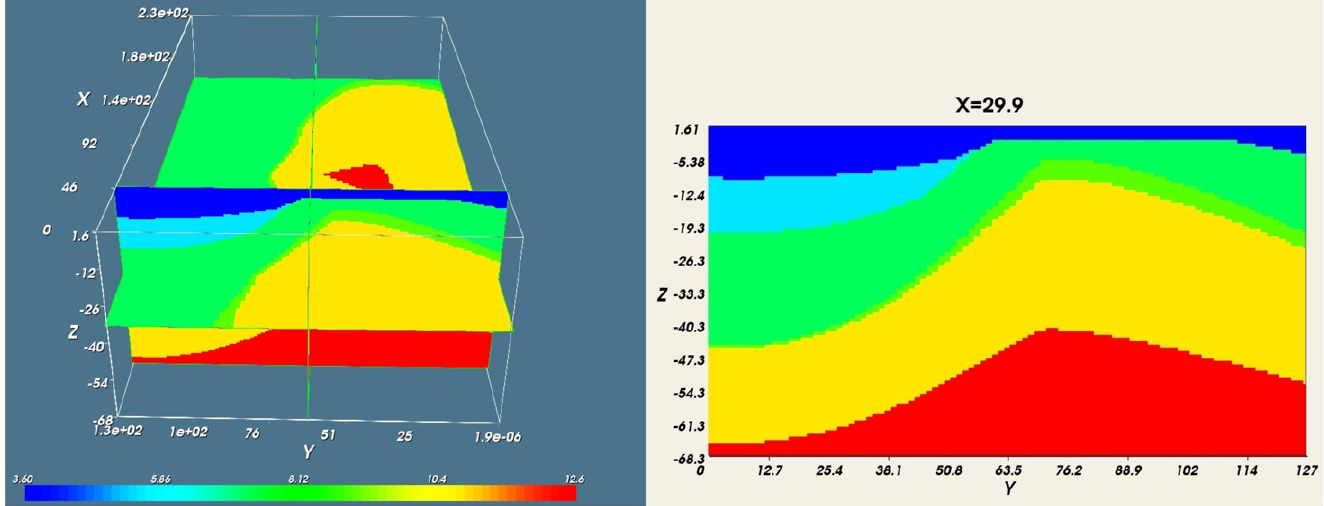
Figure 4. Vertical and horizontal slice across the model in Figure 2 (left), and vertical section in the N-S direction (right) at a distance of 29.9 km from the model